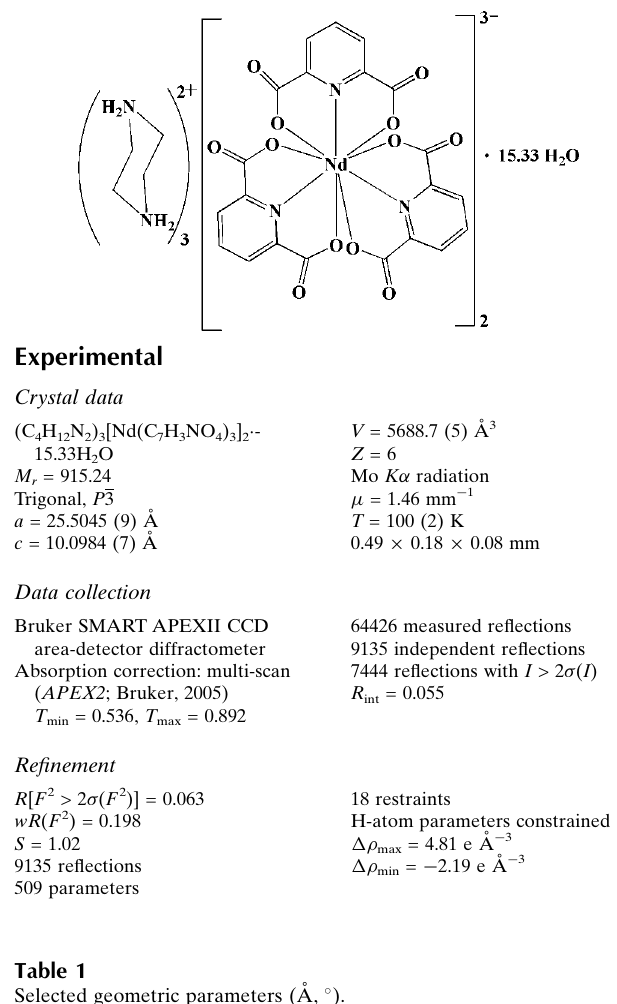
Selected geometric parameters (A˚ , (cid:4) ).